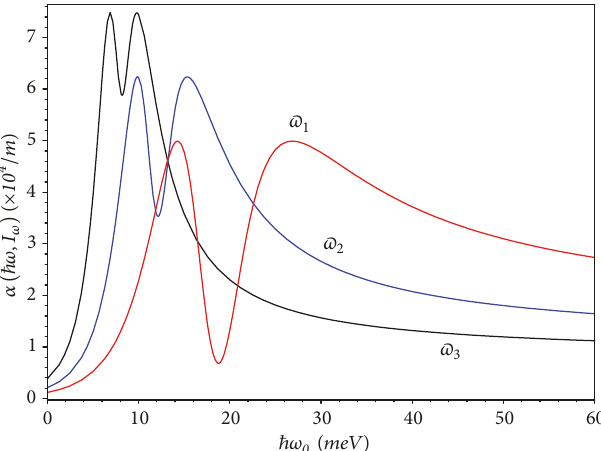
Figure 3: Variation of the (𝑙 = 1) AC (involving the ground state) with the inverse parabolic potential for a quantum wire of radius 𝑅 = 100 ˚A for the three photon energies, viz., 𝜛 1 = ℎ𝜔 = 20 𝑚𝑒𝑉, 𝜛 2 = ℎ𝜔 = 25 𝑚𝑒𝑉 , and 𝜛 3 = ℎ𝜔 = 30 𝑚𝑒𝑉 .